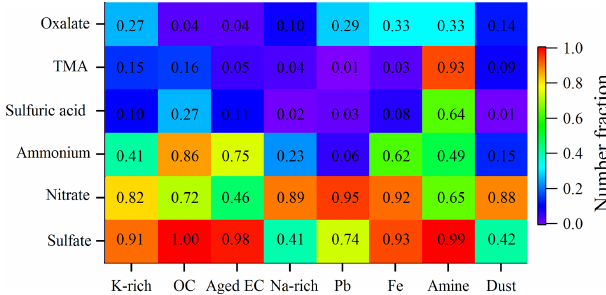
Figure 5. Number fractions of secondary markers associated with the total cloud residues types: sulfate ( m/z , − 97HSO − ( m/z , − 46NO − or − 62NO − ), ammonium ( m/z , 18NH + 2 3 ric acid ( m/z , − 195H(HSO 4 ) − ), TMA ( m/z , 59N(CH 3 ) + 2 alate ( m/z , − 89HC 2 O − 4